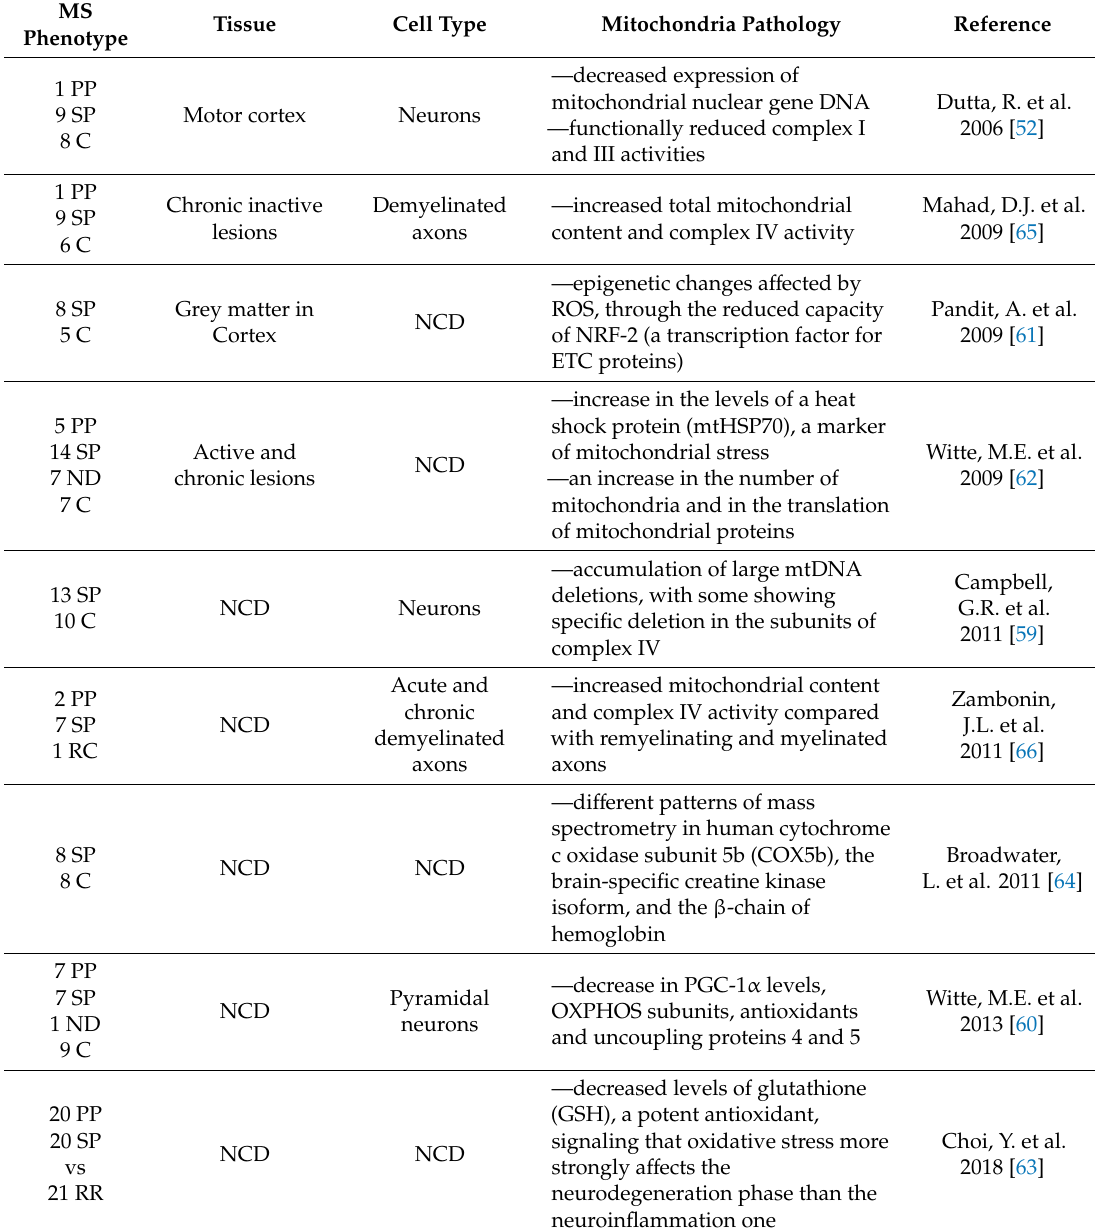
Table 1. Evidence of mitochondrial involvement in Progressive Forms of Multiple Sclerosis compared to Controls or